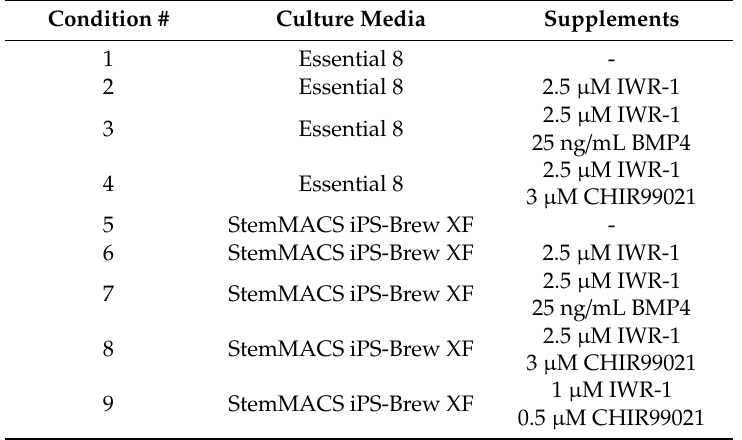
Table 4. Tested conditions to develop a feeder-free cultivation method for both, NHP- and human